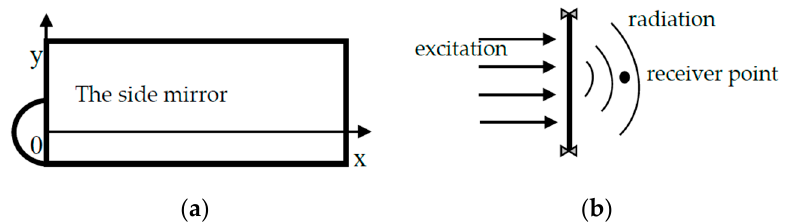
Figure 2. ( a ) The position relationship between the panel and the side mirror ( b ) The distance between the receiver point and the panel.